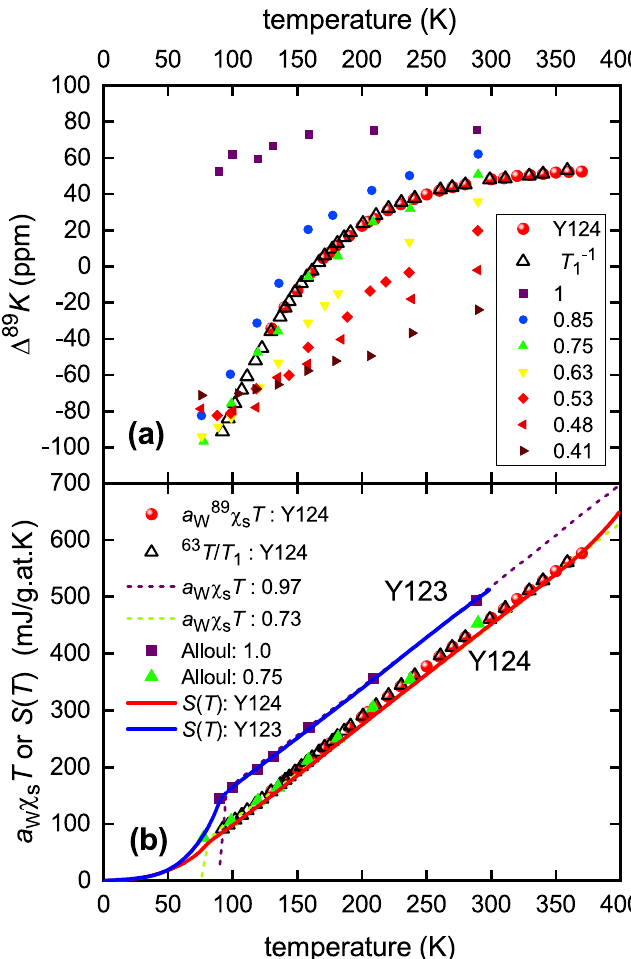
Figure 7. ( a ) 89 Y NMR Knight shift for YBa 2 Cu 3 O 6 x as reported by Alloul et al. 36 with x values annotated. + Also shown is the MAS 89 Y NMR Knight shift and the scaled T variation of 1 / T 1 for YBa 2 Cu 4 O 8 as reported by Williams et al. 39 . ( b ) Y123: Entropy S (blue solid curve 24 ), a W 89 χ s T (purple squares 36 ) and bulk susceptibility a W χ s T (purple dashed curve 24 ) for Y123 at nearly full oxygenation. Y124: entropy S (red solid curve—this work), a W 89 χ s T (red spheres 37 ) and T / 63 T 1 (open black triangles 21,39 ) for Y124. Then, as a proxy for Y124: 0.75 (solid green triangles—Alloul 36 ); and a 0.73 (dashed a W 89 χ s T for Y123 with x W χ s T for Y123 with x = = green curve—Loram 24